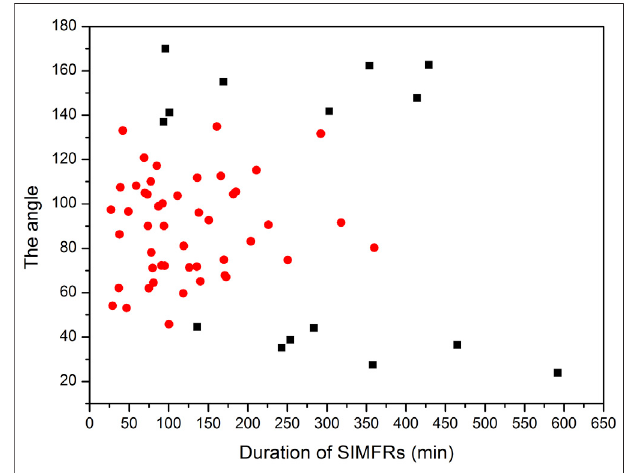
FIGURE 3 | The distribution of the latitude and longitude of the normal direction of the HCSs.